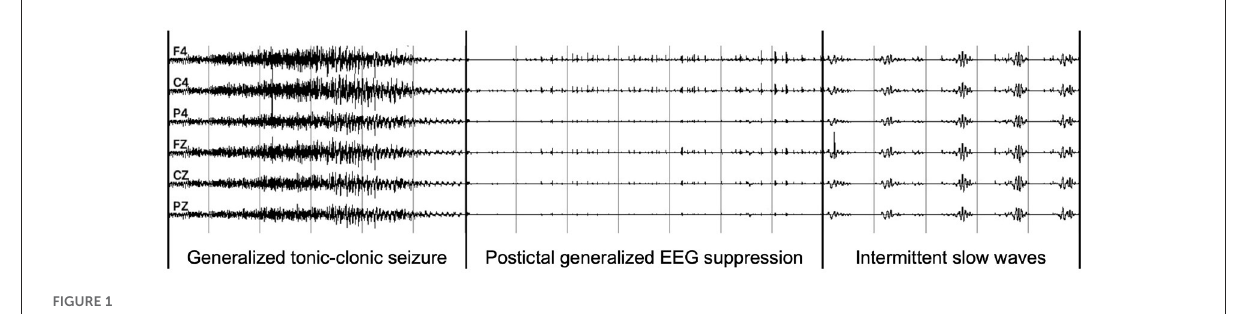
FIGURE1 An example of PGES EEG recordings after a generalized tonic-clonic